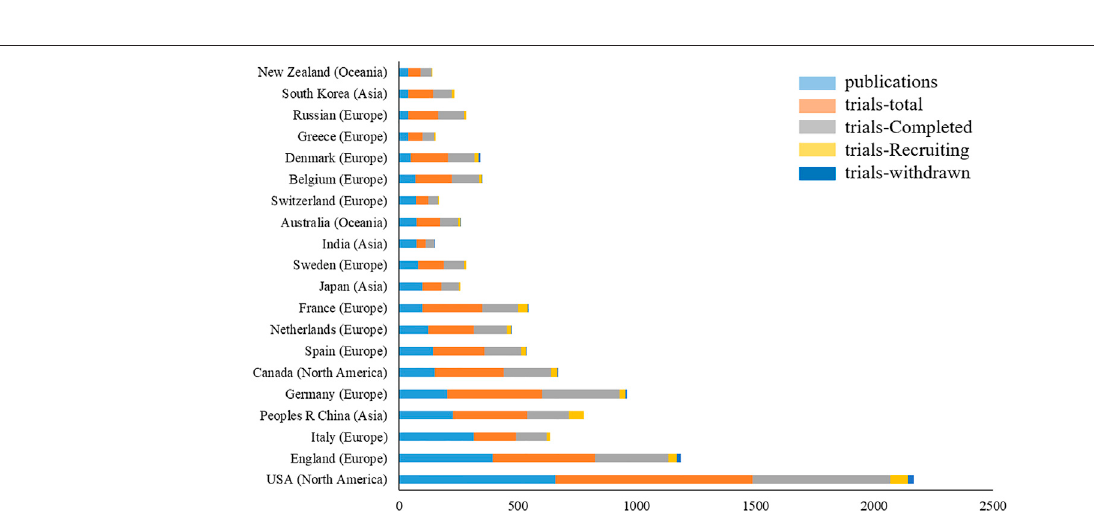
Frontiers in Pharmacology |